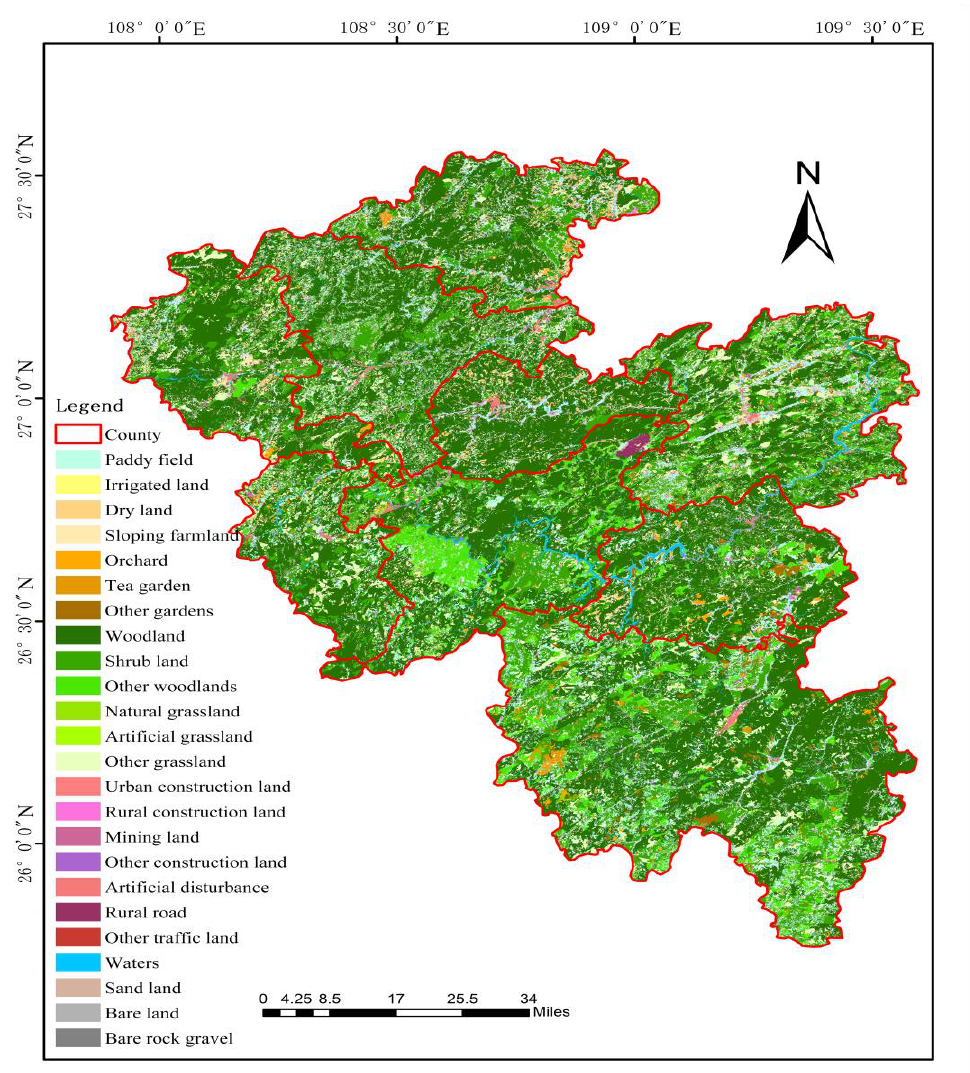
Figure 6. Thematic map of remote sensing image interpretation of one of the tributaries of the Yangtze